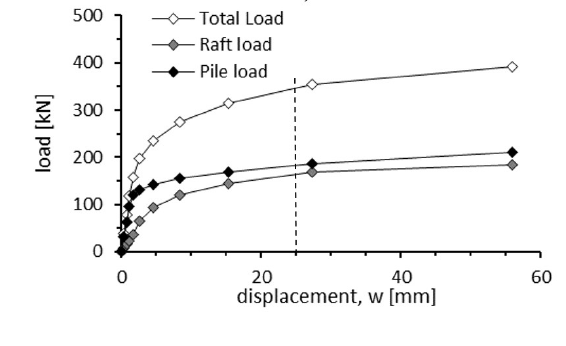
Figure 16. Load-settlement curve for case 9 - L=5m; t=0.1m